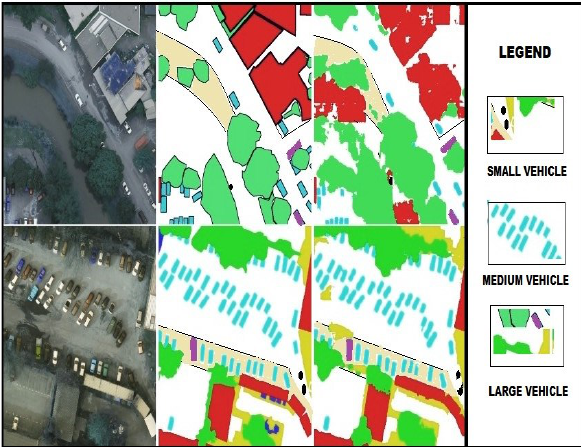
Figure 2. Semantic segmentation of vehicles on the basis of small, medium and large vehicles of google earth image